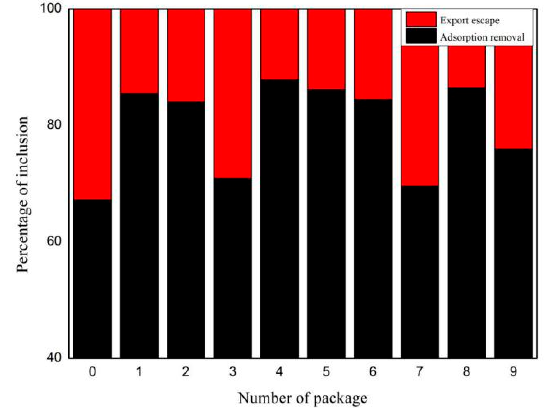
Figure 12. Stacked histogram of removal rate of fine inclusions. Table 5. The range and variance of the removal rate of fine inclusions in different schemes.